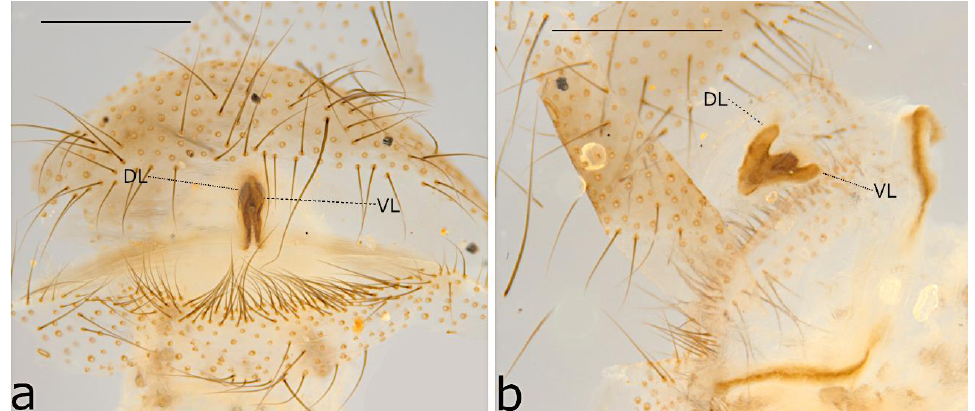
Figure 72. Ariadna valida sp.